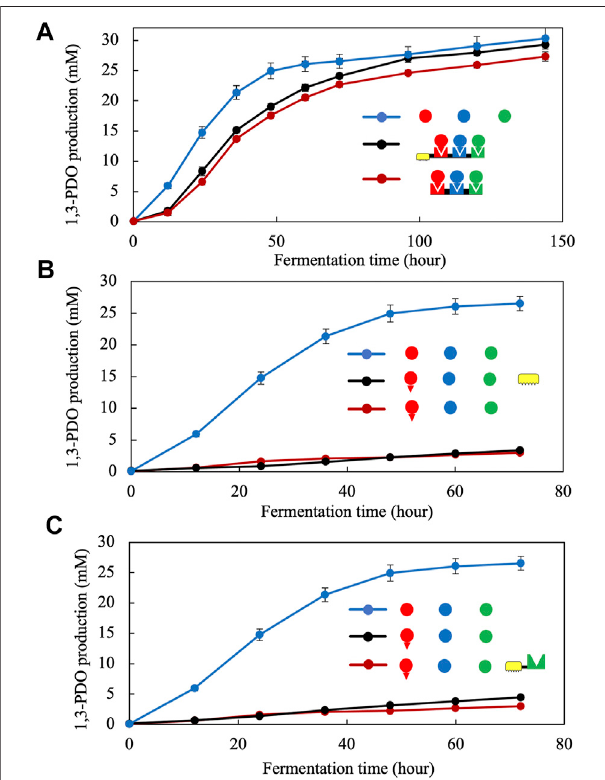
FIGURE 4 | Effect of the CBM3a on the activity of the metabolon and comparison at longer fermentation times (A) . Effect of potential non-speci fi c interactions between the CBM3a and the dockerin of dhaB1-AcDoc on the activity dhaB1-AcDoc (B) . Effect of non-speci fi c interaction between a cohesinand thedockerinofdhaB1-AcDoc ontheactivity ofdhB1-AcDoc (C) . All symbols are described in Figure 1 . Standard deviation isshown as vertical bars for each data